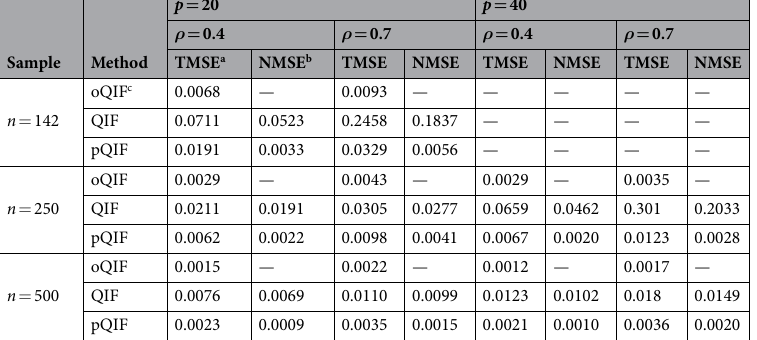
Table 1. Estimation accuracy of parameters for the QIF and pQIF under different model conditions. Since the pQIF did not converge well for n = 142, p = 40 in some simulations runs, the estimation results were not listed in the table. The notation “—” indicates that the results were not available for n = 142, p = 40, and so does for the NMSE of oQIF. a TMSE = total mean squared error for all the variables in the model. b NMSE = mean squared error for all the noisy gene variants in the model. c oQIF = Oracle